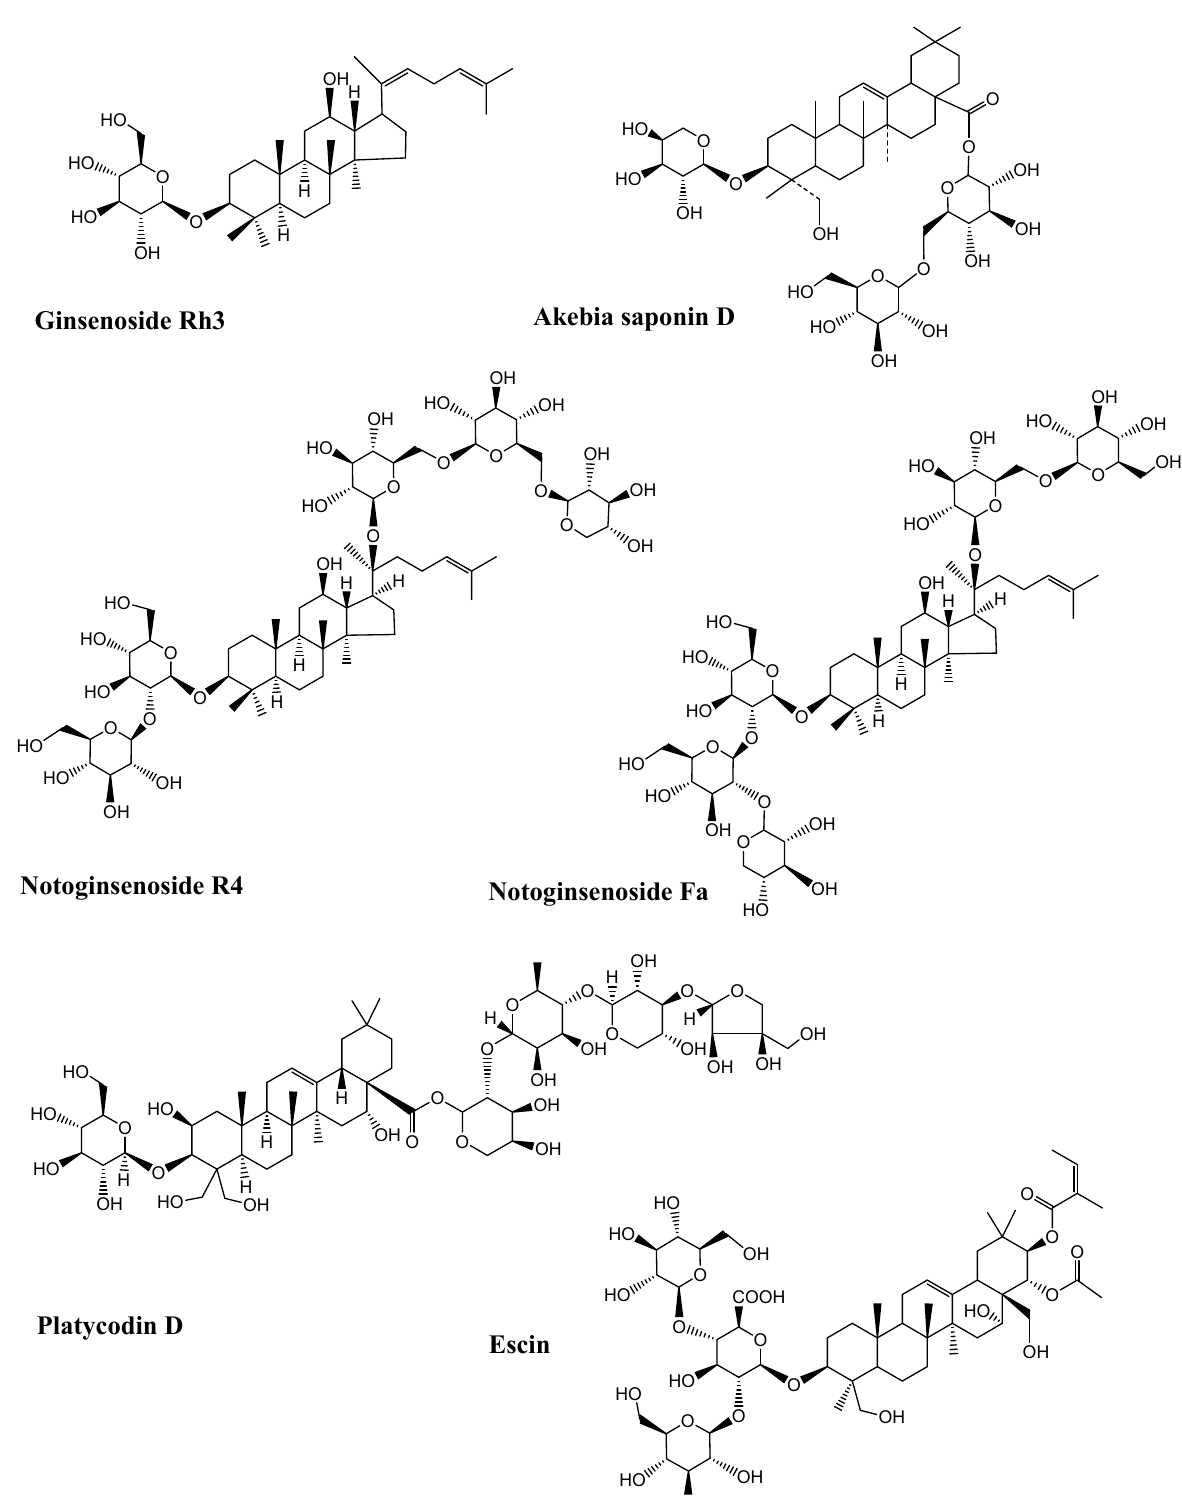
Figure 6. Chemical structure of bioactive saponins discussed in the study (Chemical structures were generated using ChemBioDraw ultra version 14).